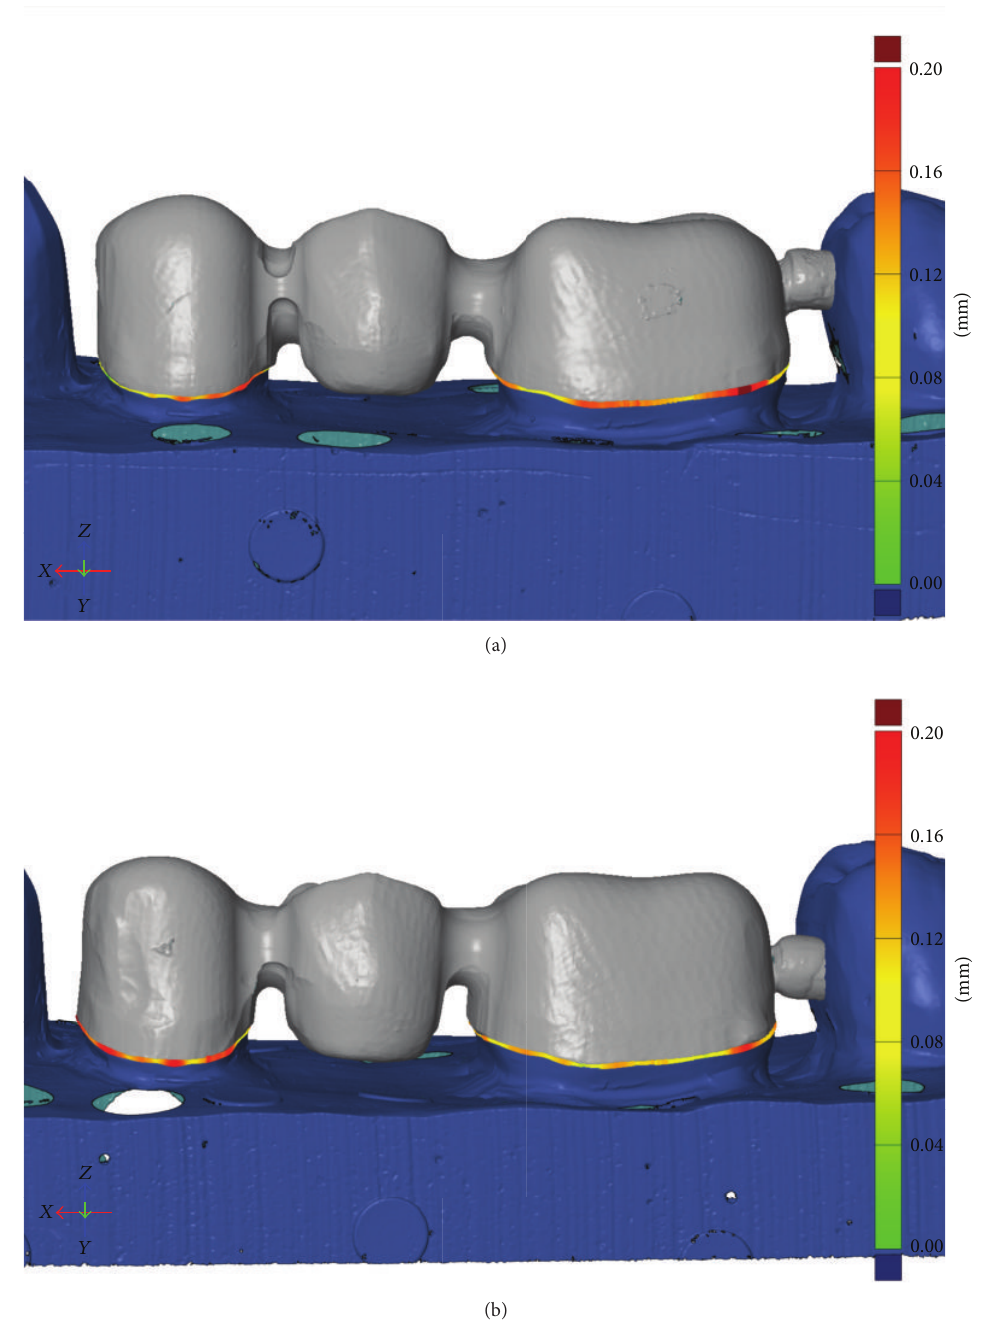
Figure 3: (a) Analysis of the absolute marginal discrepancy of FDPs produced with the conventional impression technique. The distance from finishing line to the margin of restoration is represented in color. Green = 0–40 𝜇 m; yellow = 70–110 𝜇 m; red = 160–200 𝜇 m. (b) Analysis of the absolute marginal discrepancy of FDPs produced with the digital impression technique. The distance from finishing line to the margin of restoration is represented in color. Green = 0–40 𝜇 m; yellow = 70–110 𝜇 m; red = 160–200 𝜇